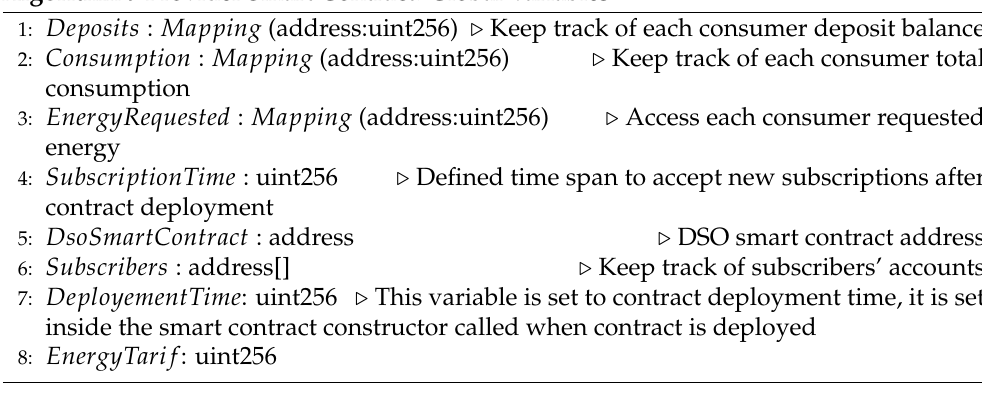
Algorithm 9 Provider Smart Contract: Global Variables